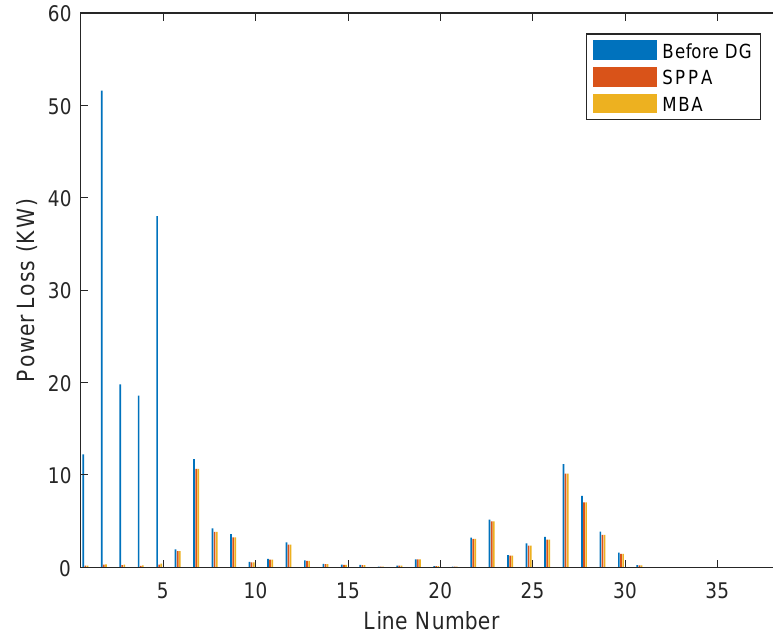
Figure 3. Active power loss results of NW-1.